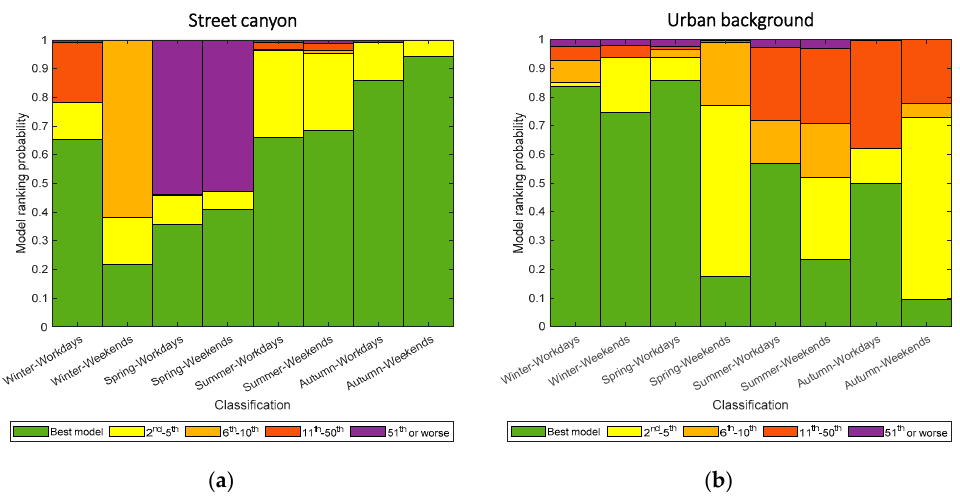
Figure 9. The probability of data points fitted by models of different rank categories (as in legend) used in input-adaptive proxy for different time classes. ( a ) and ( b ) represent the probability in Mäkelänkatu and Kumpula, respectively.